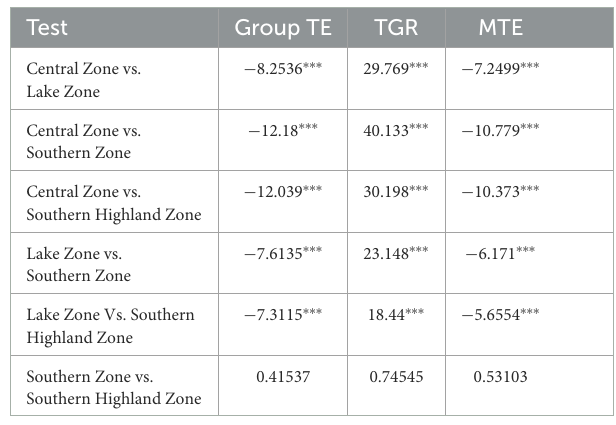
TABLE 5 T -test for various efficiency measurements across